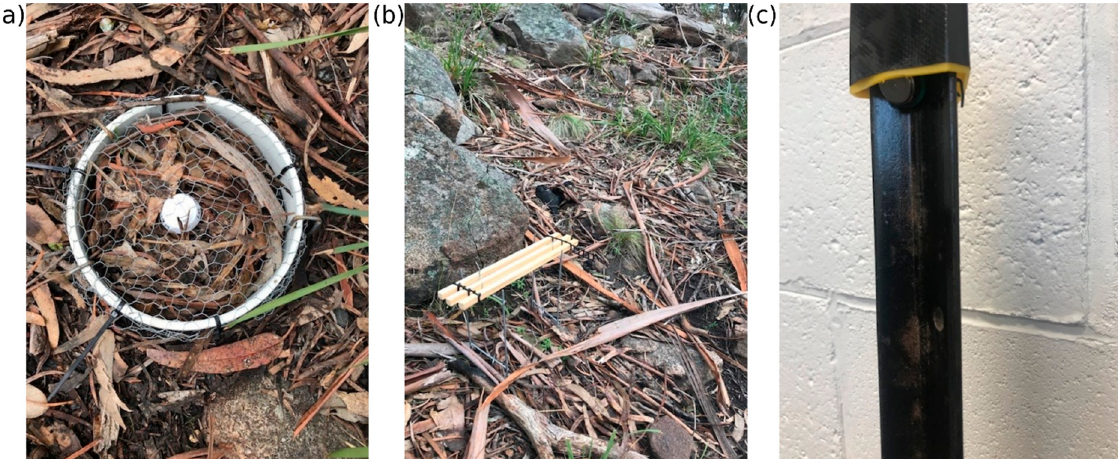
Figure 4. Photographs of equipment used to measure fine fuel moisture content. ( a ) Litter samples contained within circular cages that included a Hygrochron iButton held in a specially designed plastic case. ( b ) Three Pinus radiata fuel moisture sticks held together with plastic mesh that separates them c. 2 cm apart and supported by a wire frame 30 cm above the ground surface. ( c ) Hygrochron iButton attached to a steel stake using a specially designed fob and shielded from direct sunlight with a plastic cap.